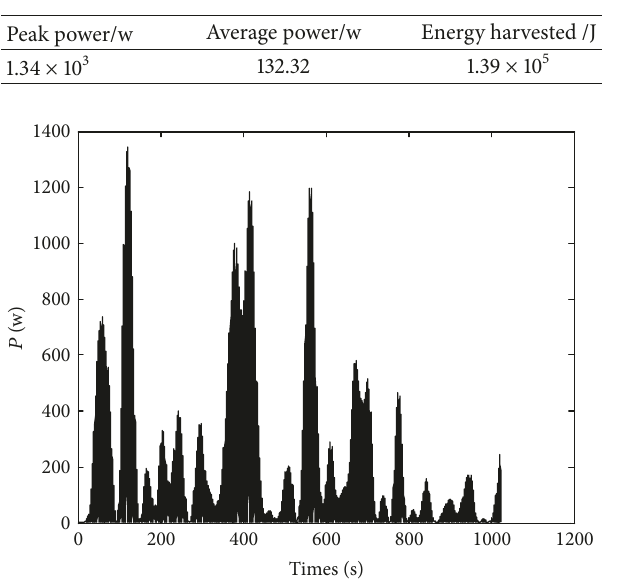
Table 2: The energy-related indicator.